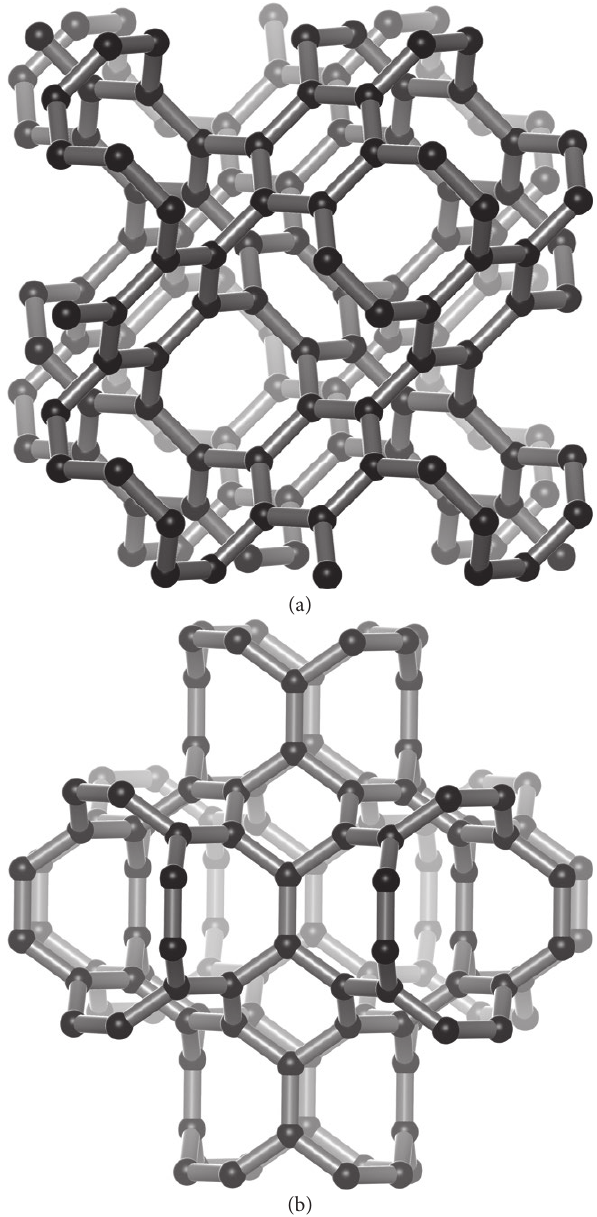
Figure 8. Cubic schwarzites containing only 6- and 8-rings: